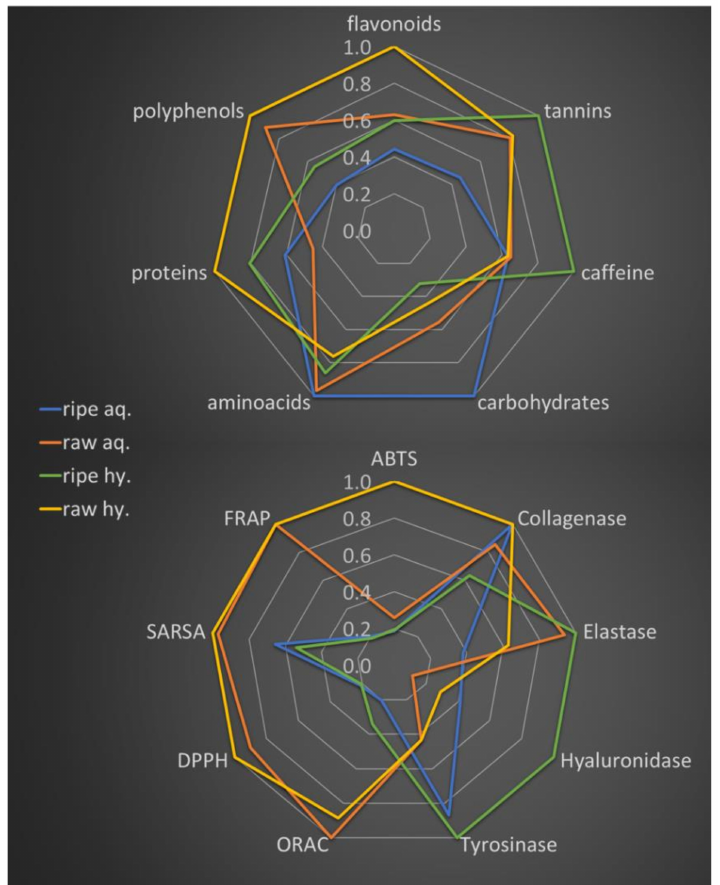
Figure 2. Normalized content in polyphenols, flavonoids, tannins, proteins, aminoacids, carbohydrates and caffeine (upper radar plot) and normalized antioxidant and enzyme inhibition activities (lower radar plot) of pu-erh tea extracts. Activities reported as trolox equivalents for ORAC, Fe 2+ equivalent for FRAP or 1/IC50 for all the other assays. (aq = aqueous extracts, Hy = hydroalcoholic